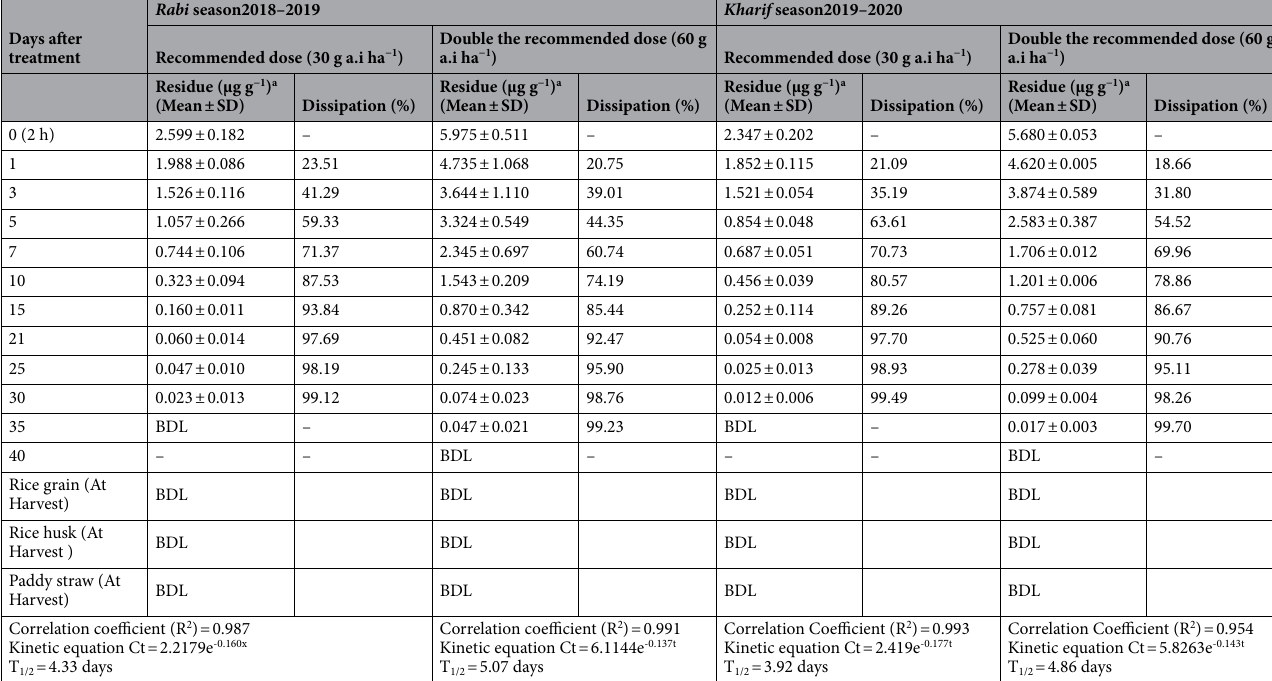
Table 4. Persistence of chlorantraniliprole 18.5%SC in paddy leaf at recommended and double the recommended